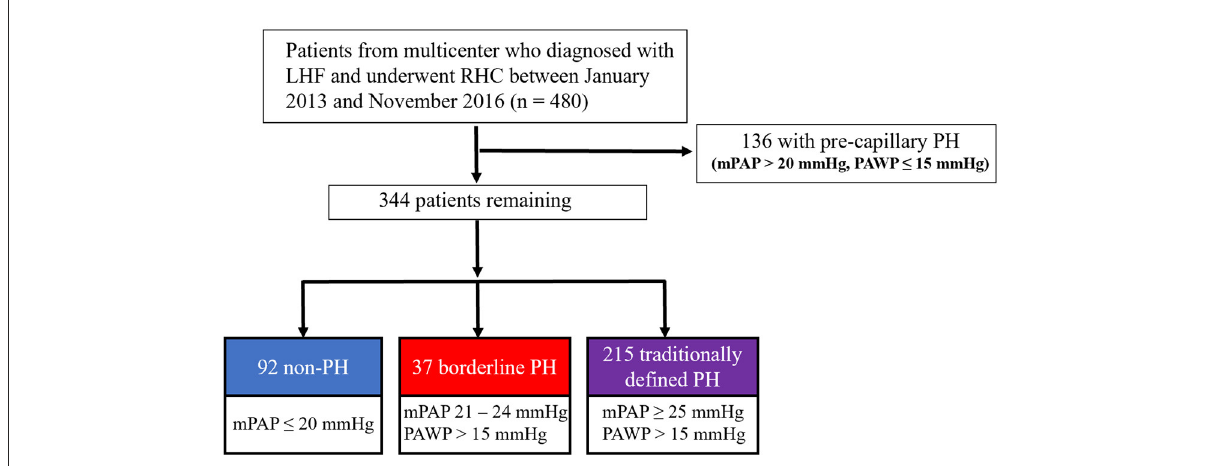
FIGURE1 The study design and flowchart for the selection of patients. LHF, left heart failure; RHC, right heart catheterization; PH, pulmonary hypertension.